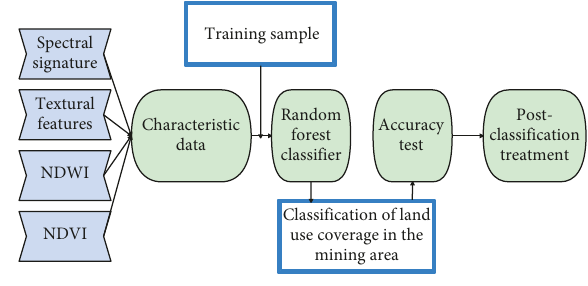
Figure 5: Classification